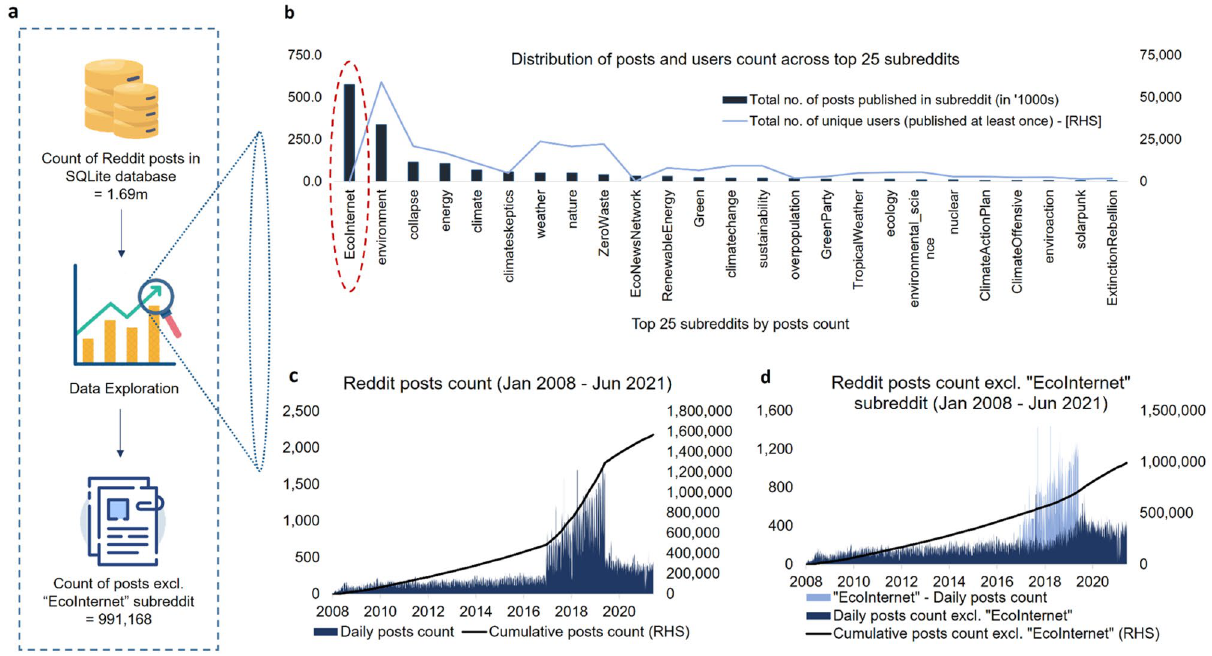
Figure 2. Data exploration and finalization. Overall we observe a gradual increase in the posts count over the study period except for a single time period from Jan 2017 to Jun 2019 ( c ). From the total number of c.1.7 m posts collected from 55 climate related subreddits, the EcoInternet subreddit alone accounted for c.35% of the posts ( b ). However, it was active only for a relatively short period of time from Jan 2017 to Jun 2019 ( d ), and only a single Reddit user namely EcoInternetNewsfeed was responsible for publishing c.99% of the total posts within EcoInternet during that time frame, resulting in a very small and disproportionate user base as compared to other subreddits—highlighted using red dotted line ellipse above ( b ). After excluding the data from EcoInternet subreddit, we observe a gradual increase in posts count over the entire study period (2008–2021) ( d ). Considering it as an outlier, we exclude all of the posts from EcoInternet subreddit, and finalize 991,168 posts ( a ) from the rest of the 54 subreddits for further